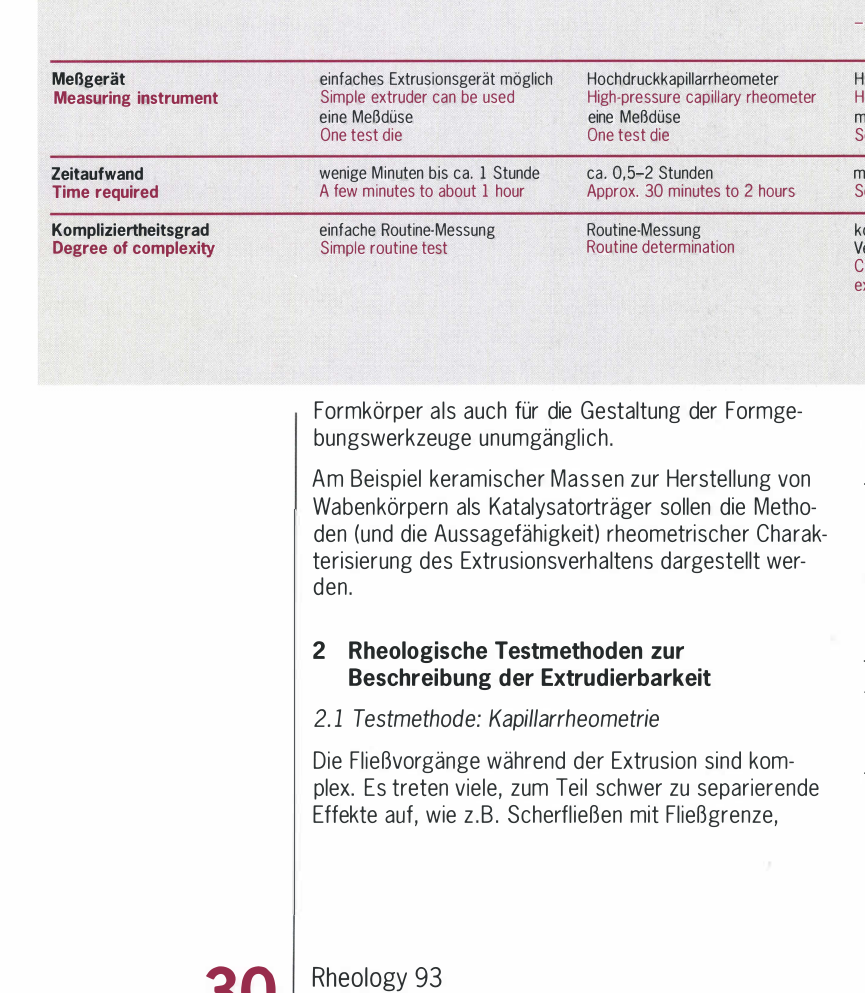
Fig. 3: Capil/ary-rheometric determinations of